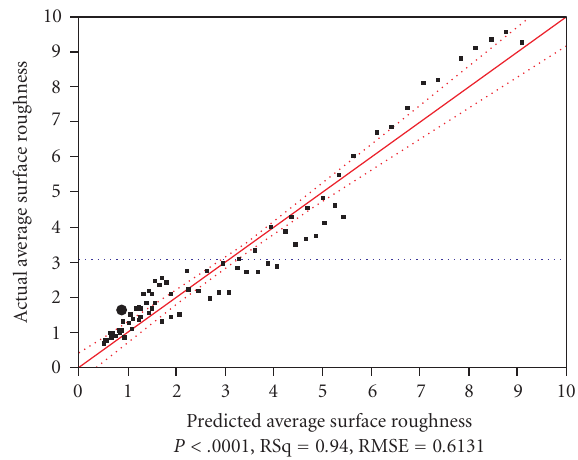
Figure 7: The actual surface roughness versus predicted surface roughness of main e ff ects and interaction terms model.